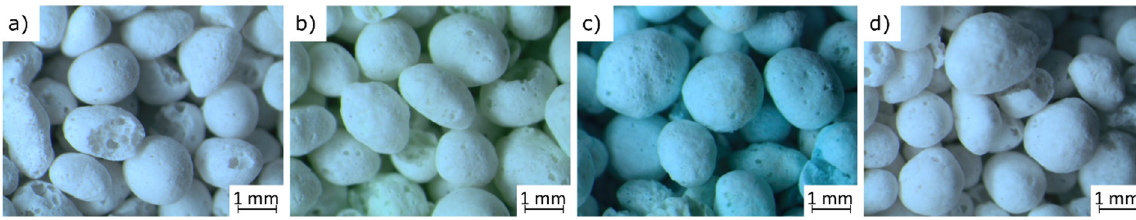
Figure 1. Zeolite lightweight aggregate as the reference sample analyzed ( a ) and impregnated with Ni 2+ ( b ), Cu 2+ ( c ), and Zn 2+ ions ( d ).